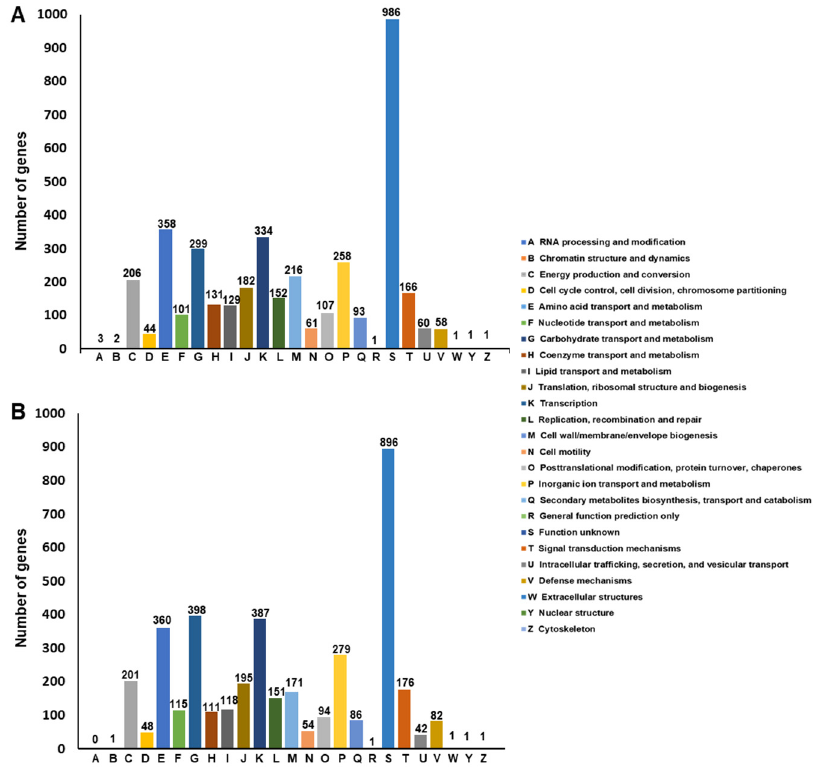
Figure 3. The COG function annotation of SF106 ( A ) and SF174 ( B ). The total number of proteins assigned to each category is indicated.